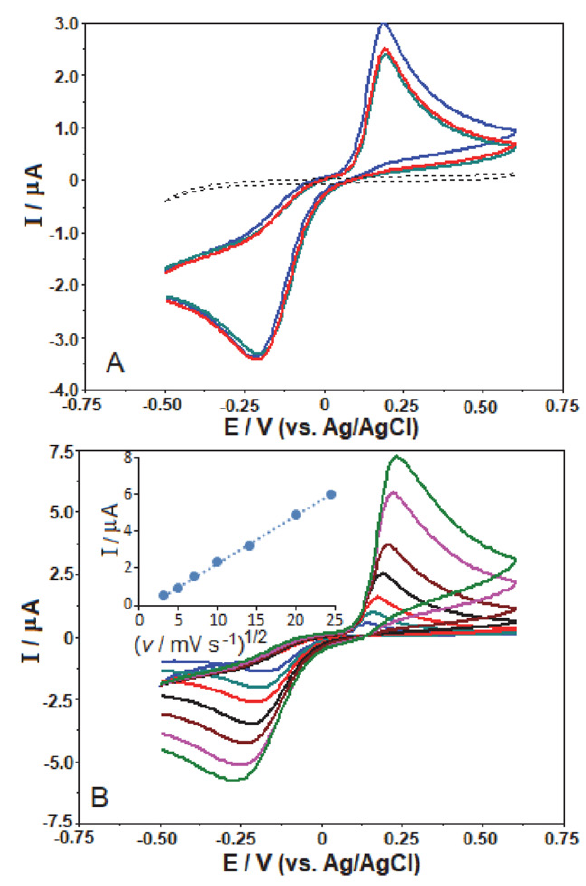
Figure 2. The repetitive cyclic voltammograms at scan rate of 100 mV s –1 (A), and the cyclic voltammograms at different scan rates (10, 25, 50, 100, 200, 400 and 600 mV s –1 ) (B) of 0.2 mM lawsone solutions in 0.1 M phosphate buffer (pH 2.5) solution. A; Dashed lines represent background current. B; Inset depicts the plot of peak current ( I a) vs. square root of the scan rate (ν 1/2